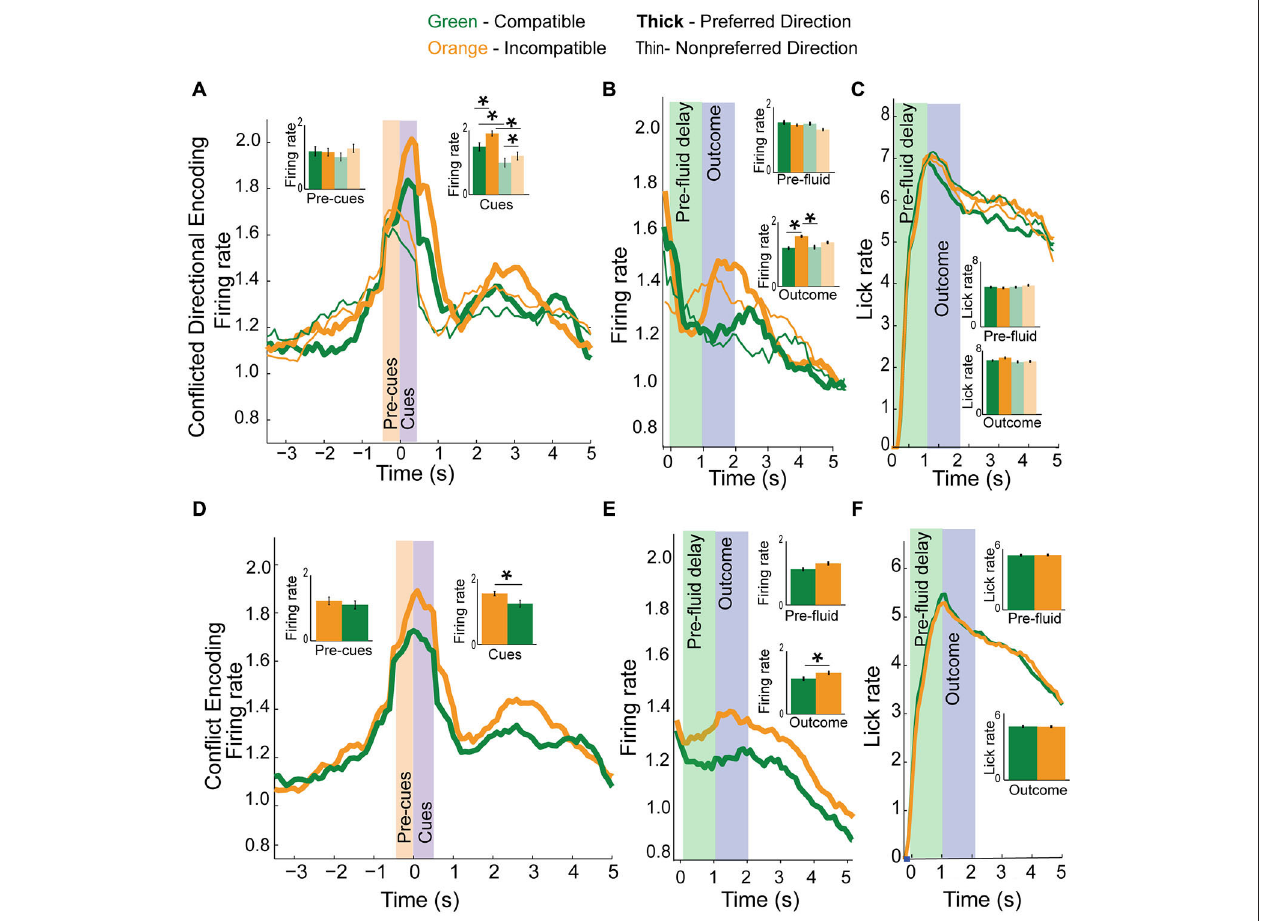
FIGURE 6 | Conflict and direction activity in the mPFC. (A) Top panel plots direction neurons based on preferred direction (thick) and non-preferred direction (thin) and by trial-type, compatible (green) and incompatible (orange) with inset bar graphs showing data during both pre-cue and cue epochs for correct and error (faded green and yellow) trials. While direction neurons were more active for one direction over another, activity in these neurons was more active when directional cues were in conflict than when they were compatible with each other. (B) Direction and conflict data demonstrates elevated activity for preferred direction incompatible trials during the outcome epoch, but not pre-fluid epoch. (C) Plots licking data demonstrating no difference in lick rate between trial-types. (D) Collapsing the data from (A) into compatible or incompatible trials, we see that directional neurons fire more for incompatible trial-types than for compatible trial-types when presented with cue information. (E) Activity plotted by compatibility averaged across direction during the pre-fluid and outcome epochs demonstrates a significant elevation of activity on correct incompatible trial-types compared to compatible trial-types but not during the pre-fluid epoch. (F) Plots licking rate by compatibility, and demonstrates no difference in lick rate between compatible or incompatible trial-types in either the pre-fluid or outcome epochs. Significance denoted of at least p < 0.05 with asterisk ∗